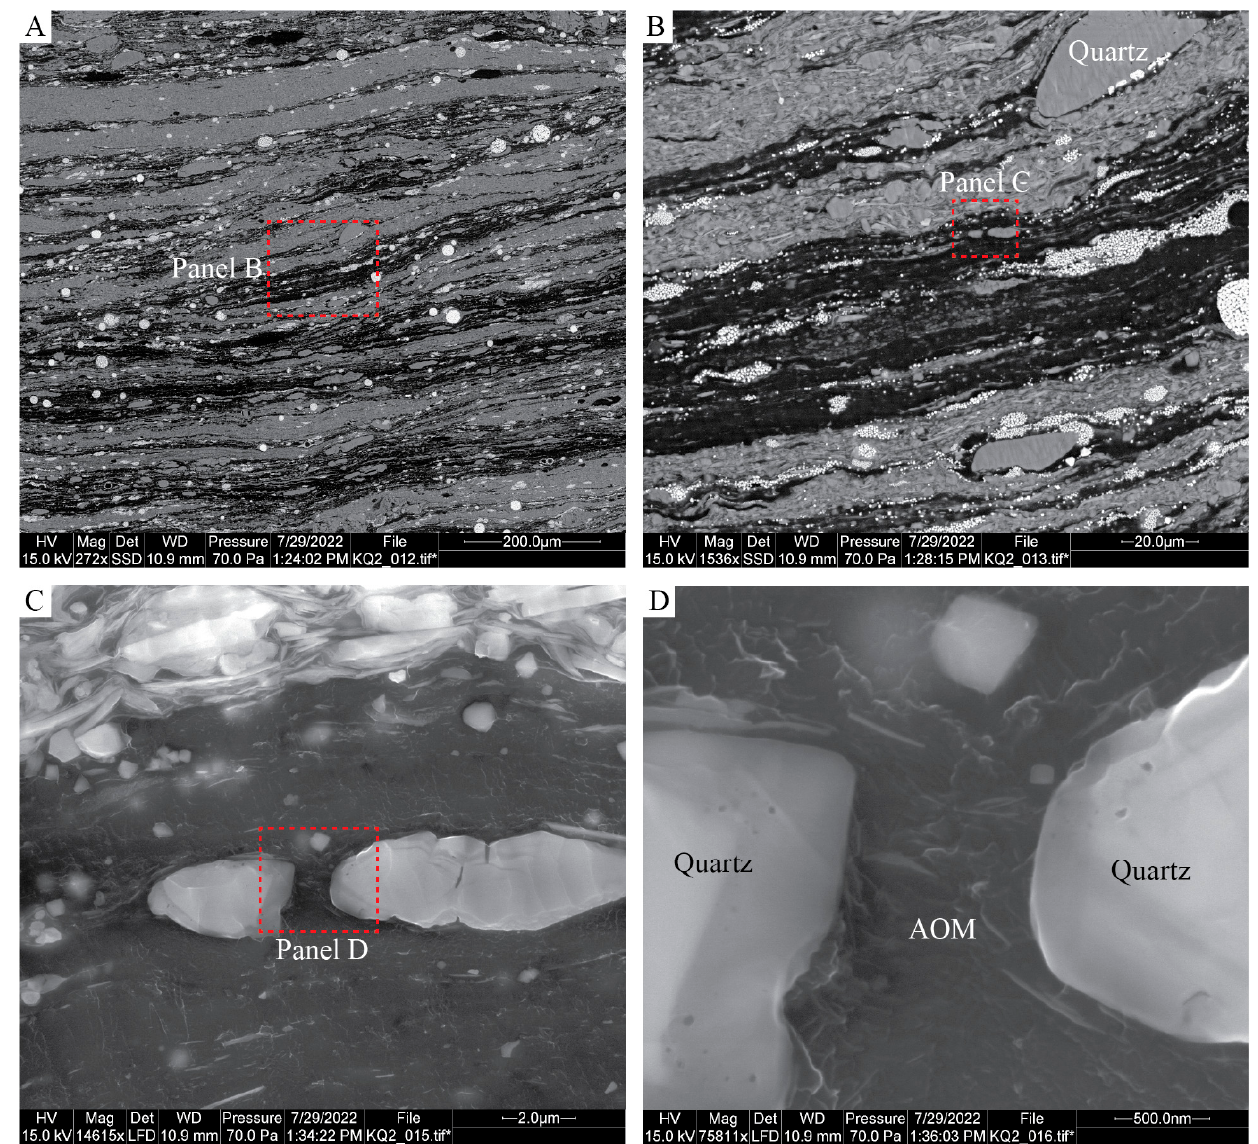
Figure 7. SEM images of amorphous organic matter (AOM), sample KQ-2. Note that AOM is mixed with mineral particles. Panels ( B , C , D ) are the close-up views of the red dashed areas in panels ( A , B , C ), respectively.